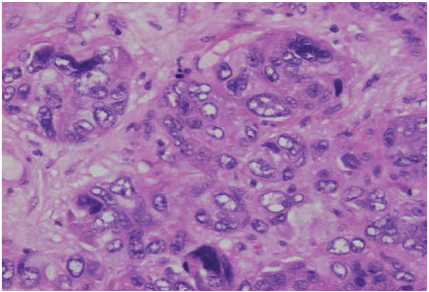
Figure 3: An area with spindle-shaped tumour cells (haematoxylin and eosin × 200).